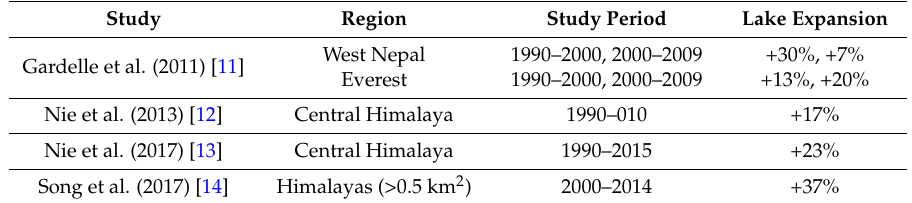
Table 1. Previous studies [11–14] that investigated regional trends of glacial lake expansion in Nepal. Study Region Study Period Lake Expansion West Gardelle et al. (2011) [11]